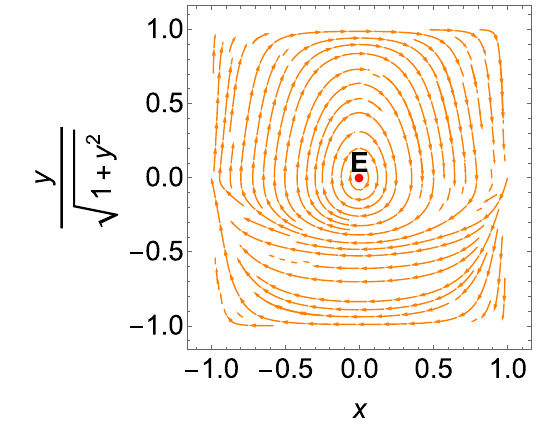
Fig. 8 Compacted phase plane of system